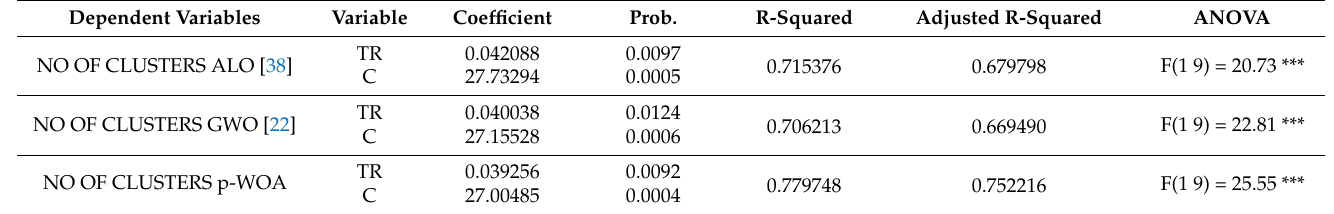
Table 2 demonstrates how clusters were affected by communication distance. Table 2. Transmission Regression Coefficients Under Fully Modified Least-Squares (FMOLS) Ap- proaches Vary Depending on the Number of